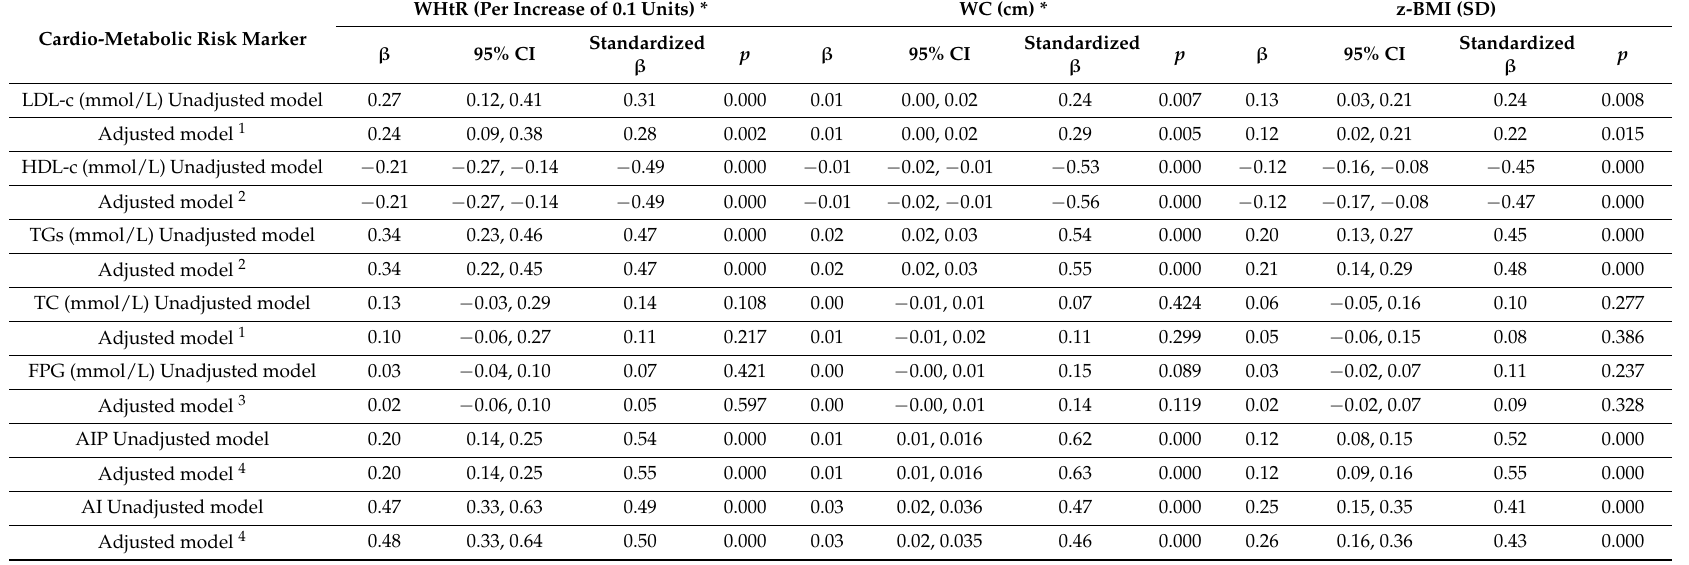
Table 4. Univariate and multivariate linear association of adiposity indicators and cardio-metabolic risk factors.